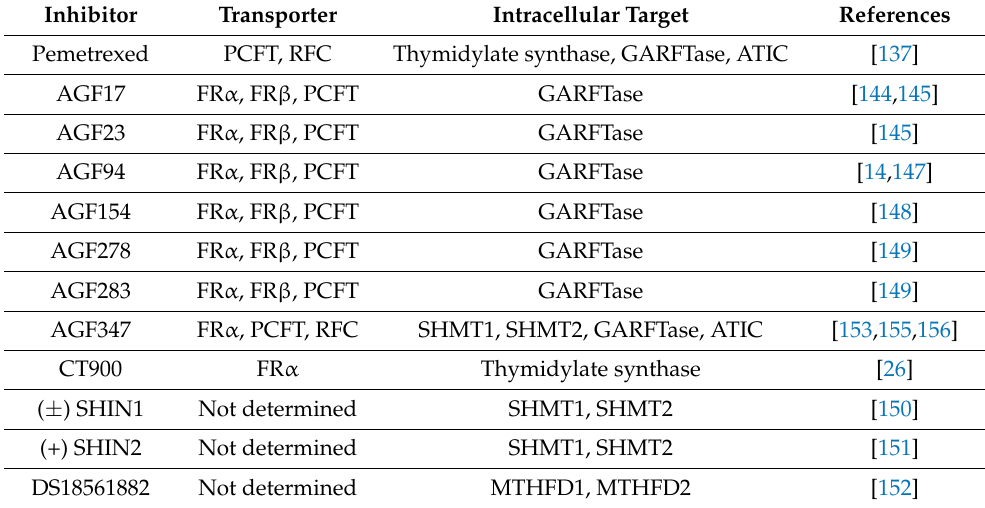
Table 2. FR and PCFT-targeted